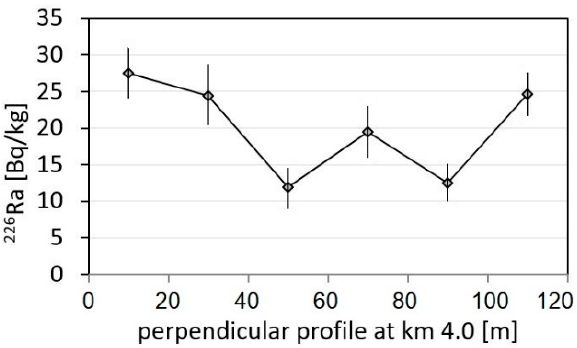
Figure 9. 226 Ra activities [Bq/kg] in Elbe sediment samples taken between Schmilka (km 0) and Pieschen (km 60).